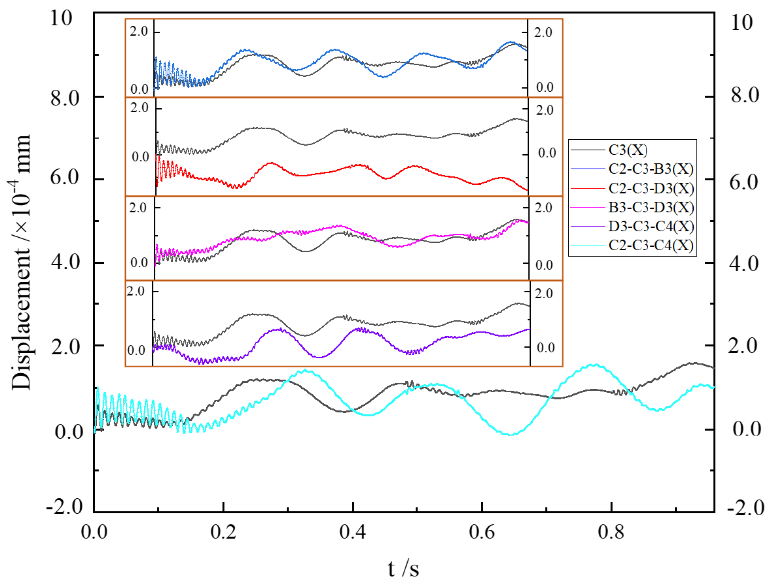
Figure 16. Radial displacement comparison of three vibrating helical tubes.